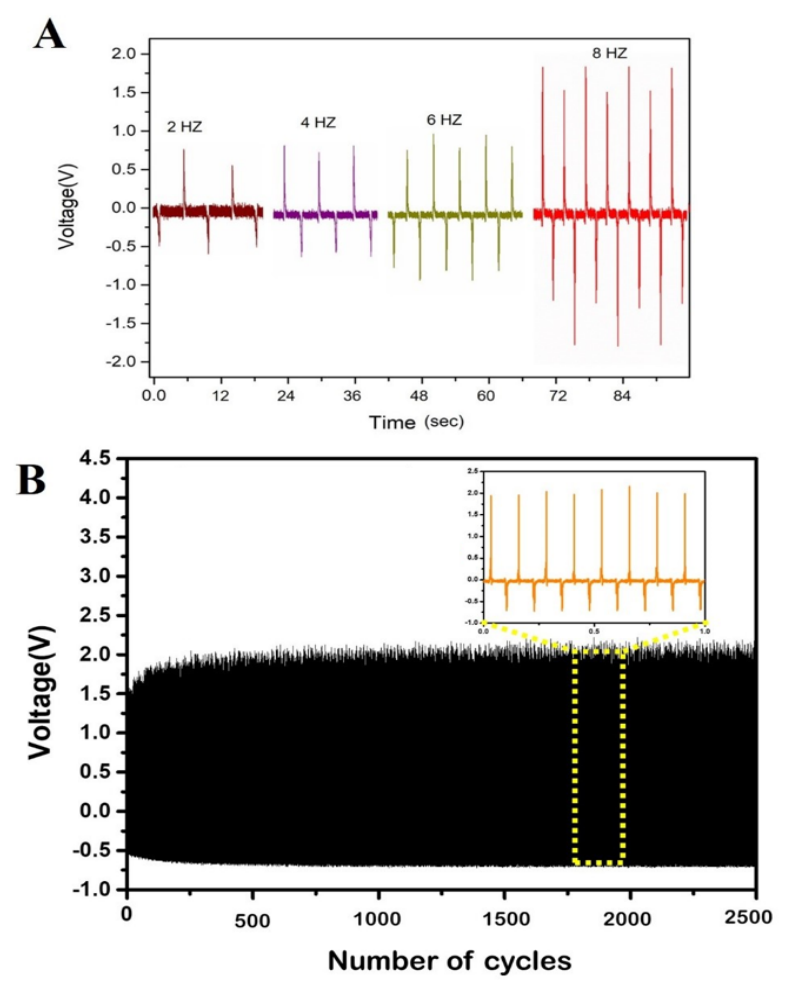
Figure 5. ( A ) The piezoelectric voltage generated from the PGANF FENG under di ff erent mechanical Figure 5. A ) The piezoelectric voltage generated from the PGANF FENG under different mechanical vibration frequency, ( B ) Mechanical durability test of the PGANF FENG under repeated pushing and vibration frequency, B ) Mechanical durability test of the PGANF FENG under repeated pushing and no pushing conditions with frequency of 8Hz at a uniform force of 12 no pushing conditions with frequency of 8Hz at a uniform force of 12 N.